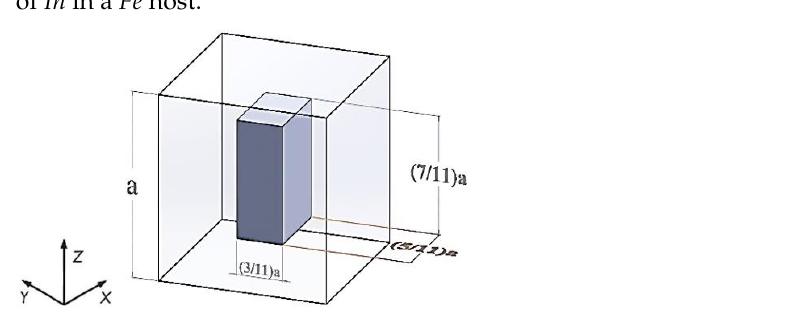
Figure 2. A 3D phononic crystal of a unit-cell cubic form with an inclusion in the form of a parallelepiped.